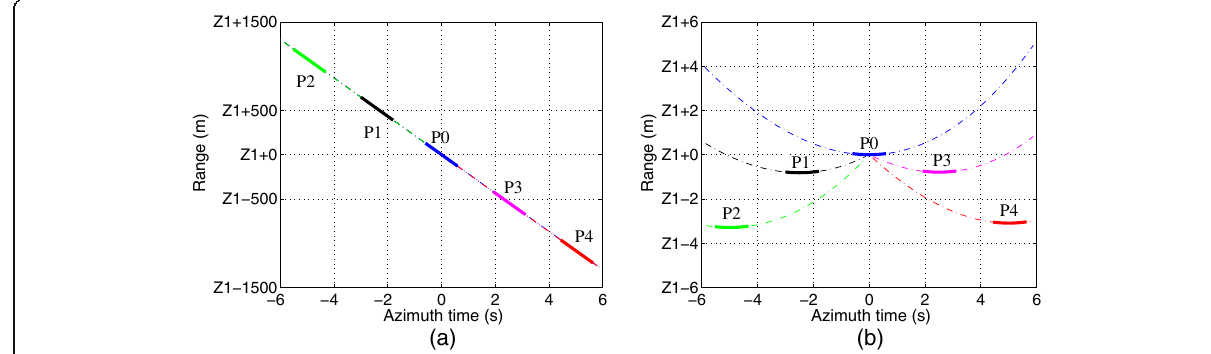
Fig. 5 Bistatic range histories of the echoes. a Before deramp operation. b After deramp operation ( Z 1 = R total (0; r c , t c ) = 50 km)